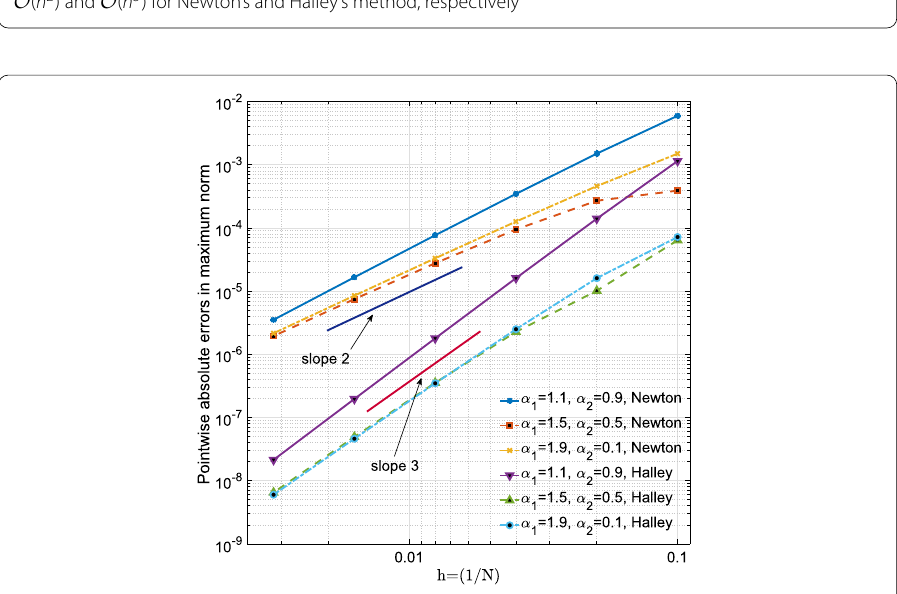
Figure 2 Pointwise absolute errors in maximum norm of Example 4.2 versus the time step h when (